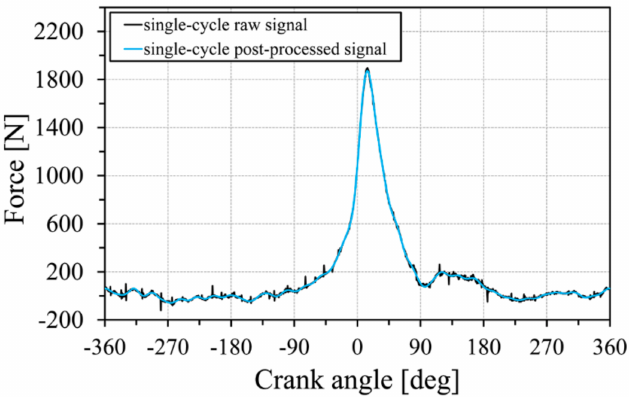
Figure 7. SW signal at 4000 rpm and full load. Single-cycle raw signal vs. Single-cycle post-processed